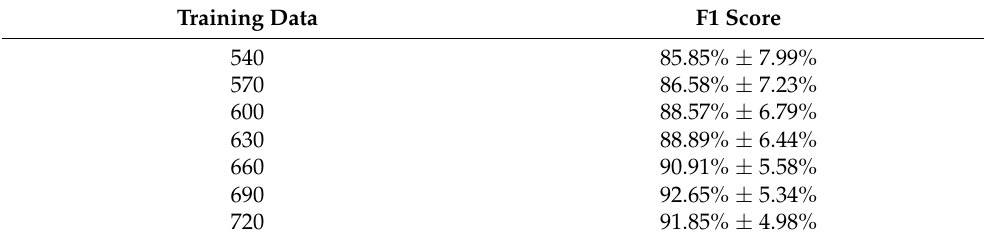
Figure 5. Average and standard deviation of the proposed method for sex recognition under differ- ent numbers of training data. Table 6. Performance of the proposed method for sex recognition as the size of training data in- creases.